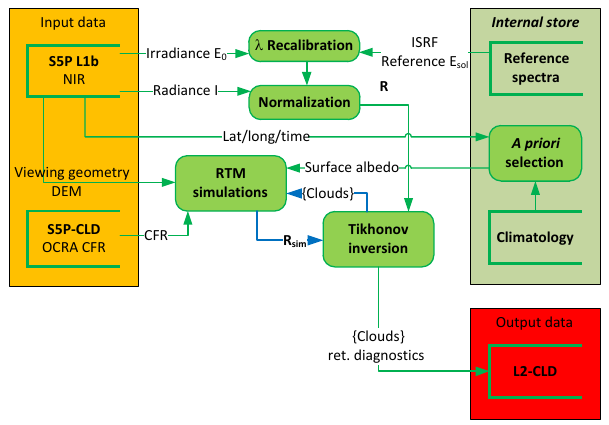
Figure 2. Flow diagram for the ROCINN algorithm for retrieval of cloud properties. The blue arrows mark an iterative